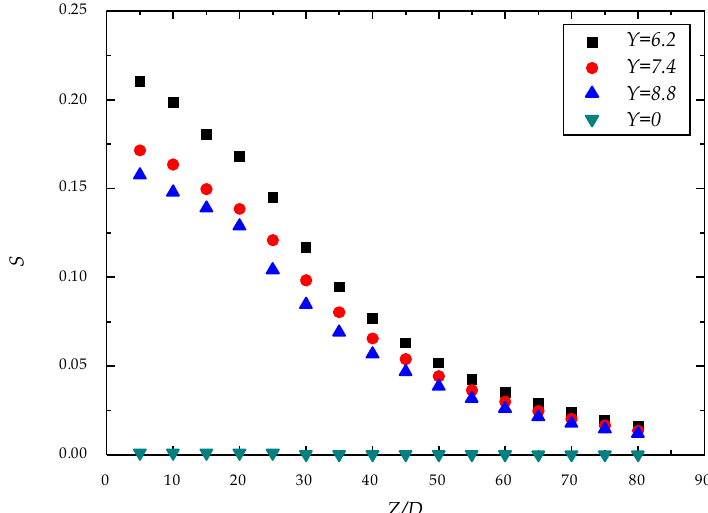
Figure 7. The swirl number at each position under different twist rates ( α 0 = 2%, Re = 20,000).